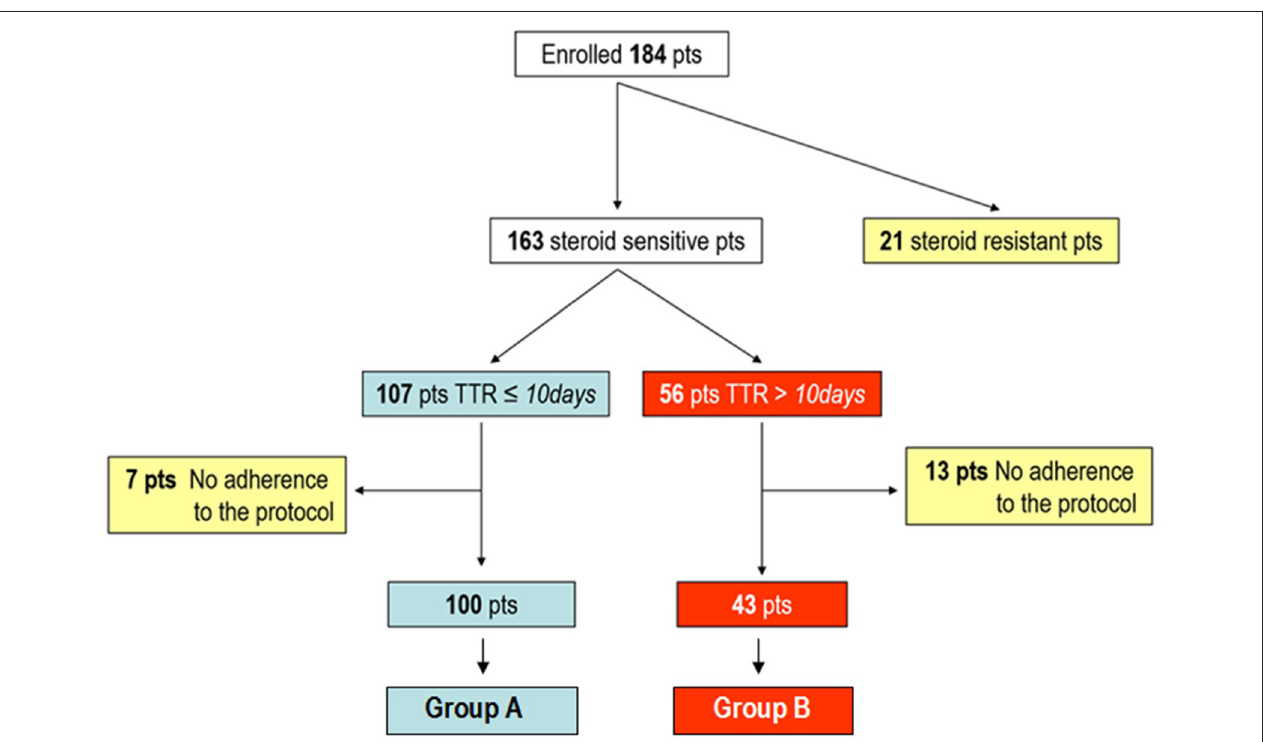
FIGURE 1 | Study flow